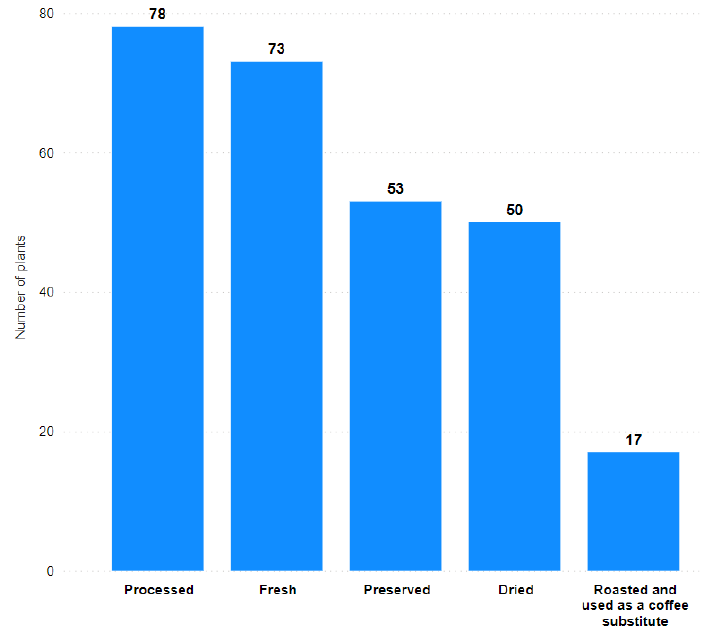
Figure 4. The ratio of preparation methods by the number of plant taxa.